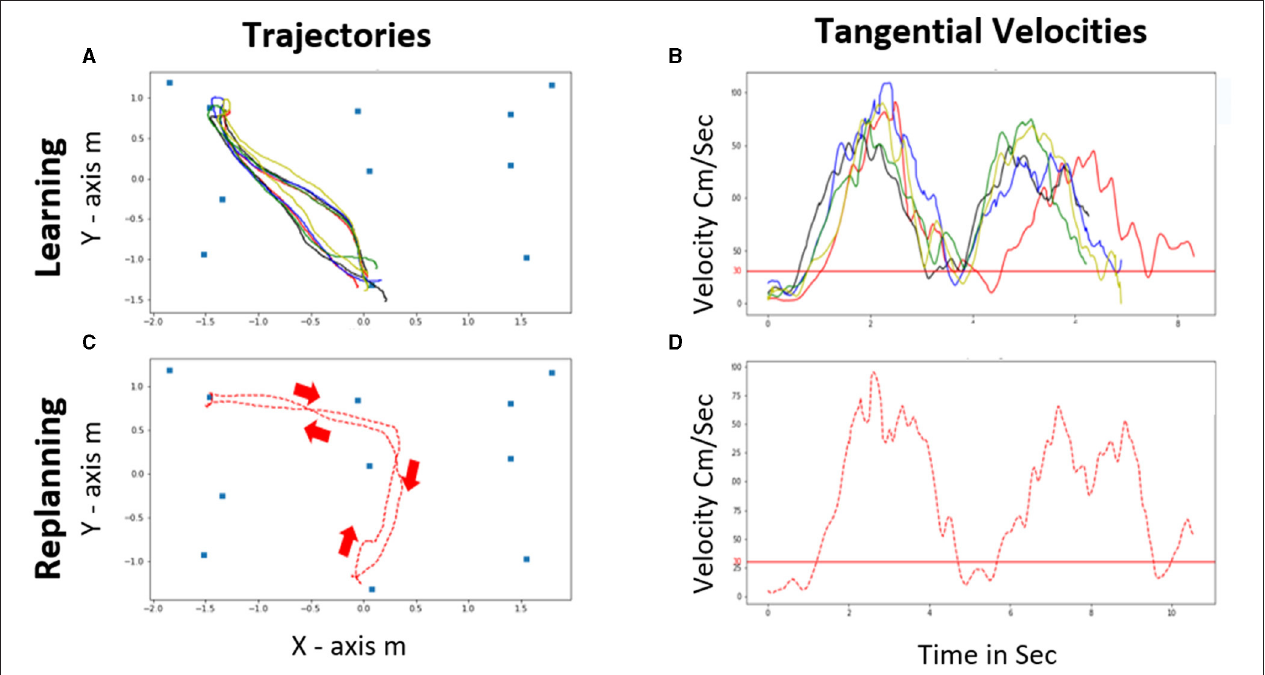
FIGURE 4 | Representation of the Learning and the Replanning phase for a single participant : (A) Trajectories and (B) tangential velocities for the learning. (C) Trajectory and (D) tangential velocity for the replanning phase for the first house. The red arrows represent the direction of the trajectories for the replanning phase showing a new direction (ND) adapted reconfiguration during the replanning.